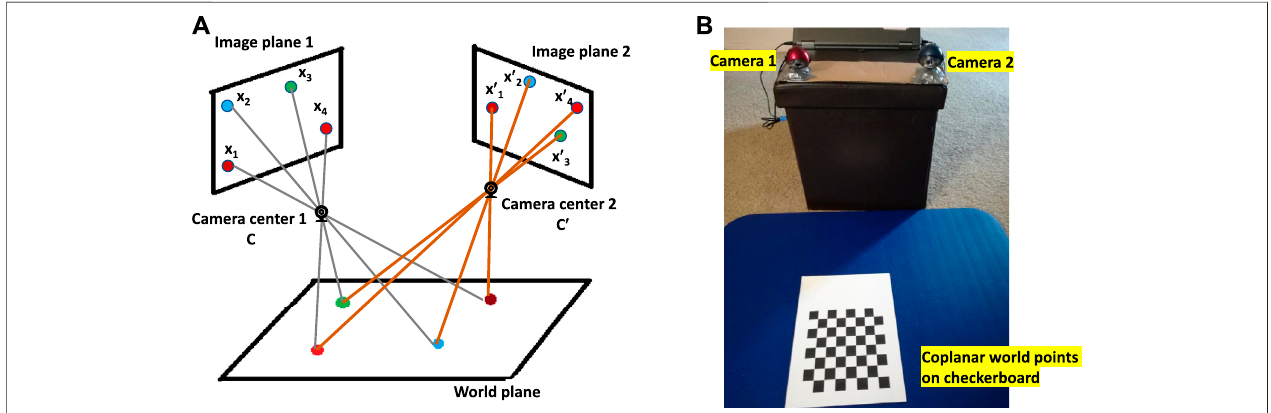
FIGURE 1 | (A) For multiple cameras, image planes are related by projective transformation when all world points are coplanar. (B) Actual setup of two cameras with coplanar checkerboard